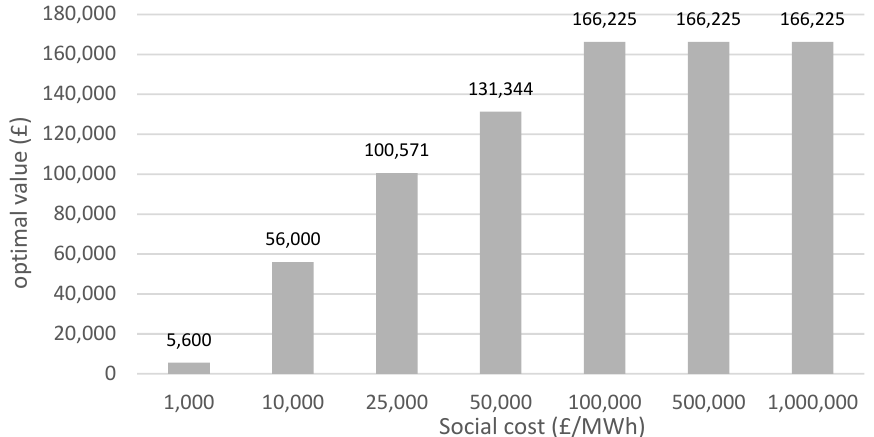
Figure 11. Optimal Value of the Objective Function as a function of social cost, using BIF.